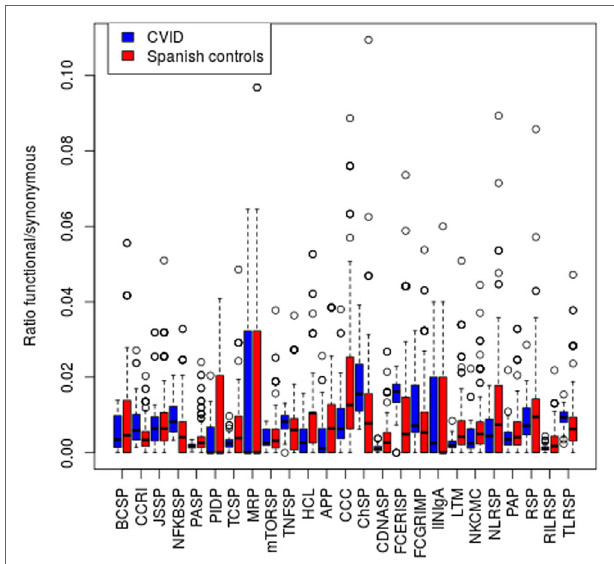
FigUre 3 | Number of functional genetic variants in common variable immunodeficiency (CVID) patients and controls in immunological pathways. Abbreviations and the number of genes in each pathway are shown in the Section “Materials and Methods.”